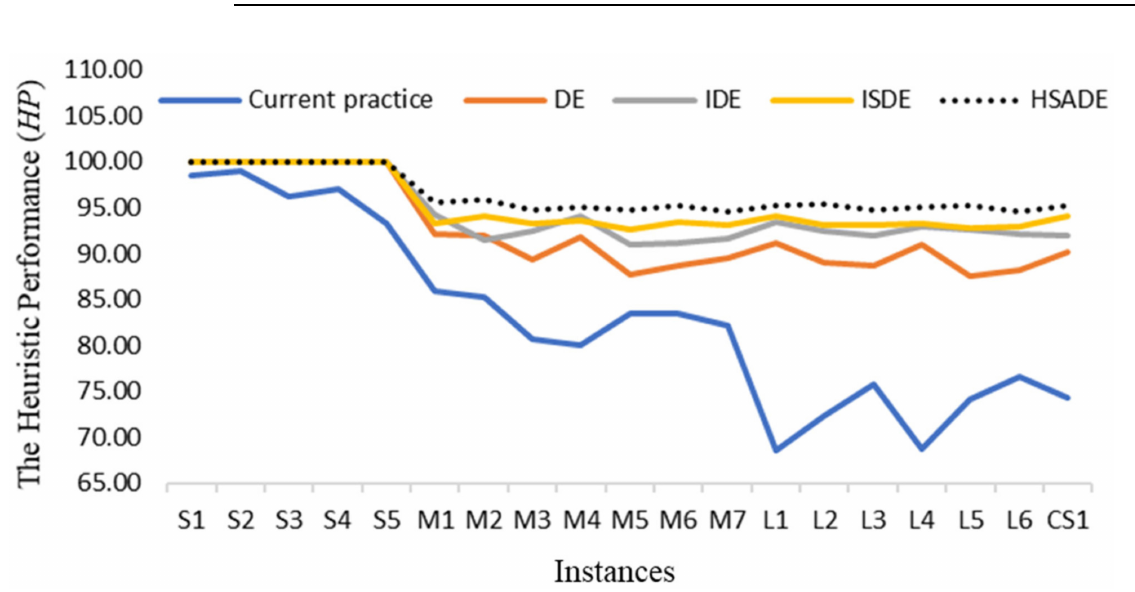
Figure 8. The heuristic performance ( HP ) results for testing